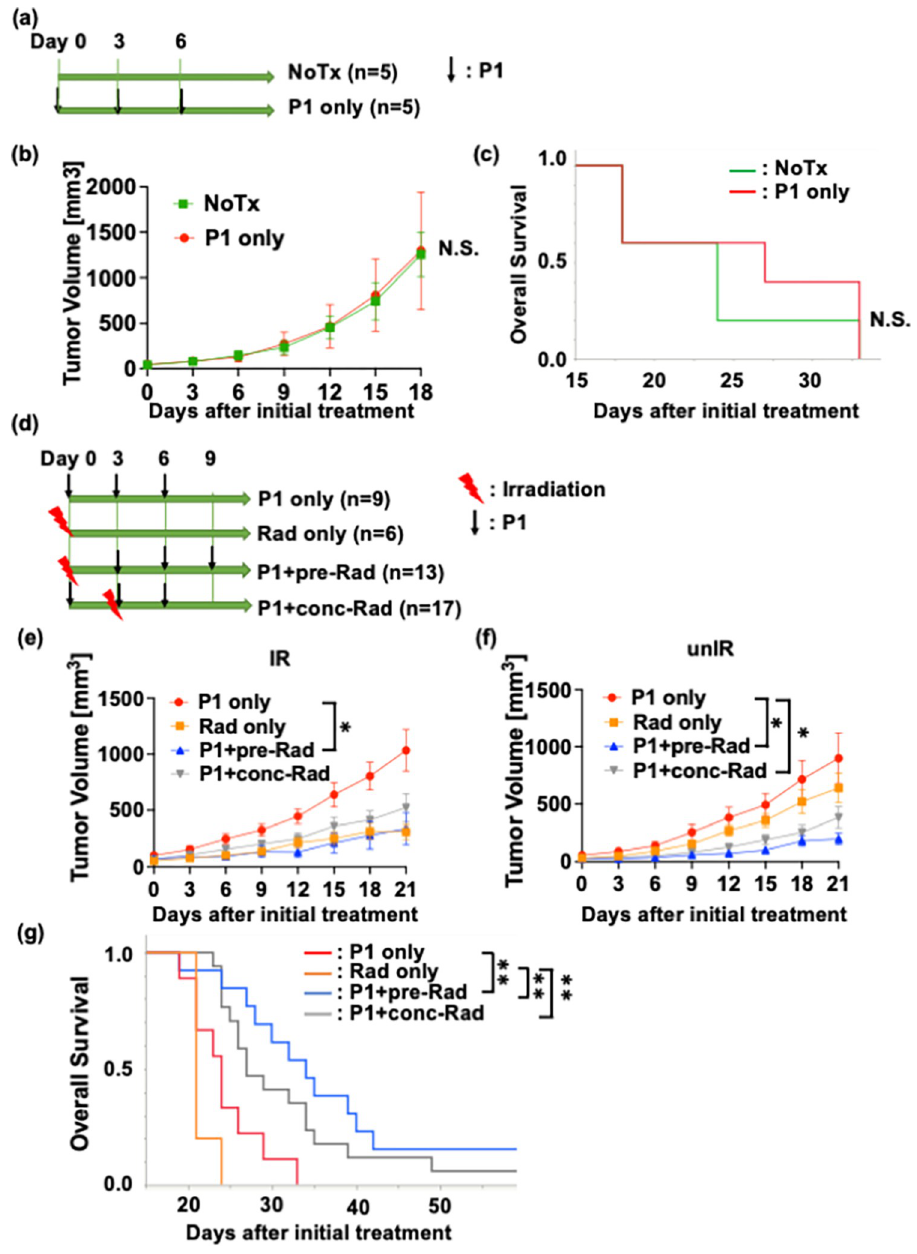
Fig 4. Comparison of treatment efficacies. (a) A treatment scheme of NoTx (n = 5), P1 only (n = 5) groups. (b and c) Tumor volume change (b) and overall survival (c) in NoTx (green) and P1 only (red) groups. Data are presented as mean ± SEM. (d) A treatment scheme in P1 only (n = 9), Rad only (n = 6), P1+pre-Rad (n = 13), and P1+conc-Rad (n = 17) groups. (e and f) Tumor volume change in IR (e) and unIR tumors (f). Data are presented as mean ± SEM. (g) Overall survival in P1 only, Rad only, P1+pre-Rad, and P1+conc-Rad groups. � p < 0.05, �� p < 0.01. Abbreviations; NoTx: no treatment, P1; anti-PD-L1 antibody, Rad only: radiation only, IR: irradiated, unIR: unirradiated. https://doi.org/10.1371/journal.pone.0271205.g004 survival ( p = 0.0043 and p = 0.002, respectively). Taken together these results suggest that addi- tion of radiation to P1 therapy is necessary to enhance systemic antitumor immune response and improve survival regardless of sequence of radiation.